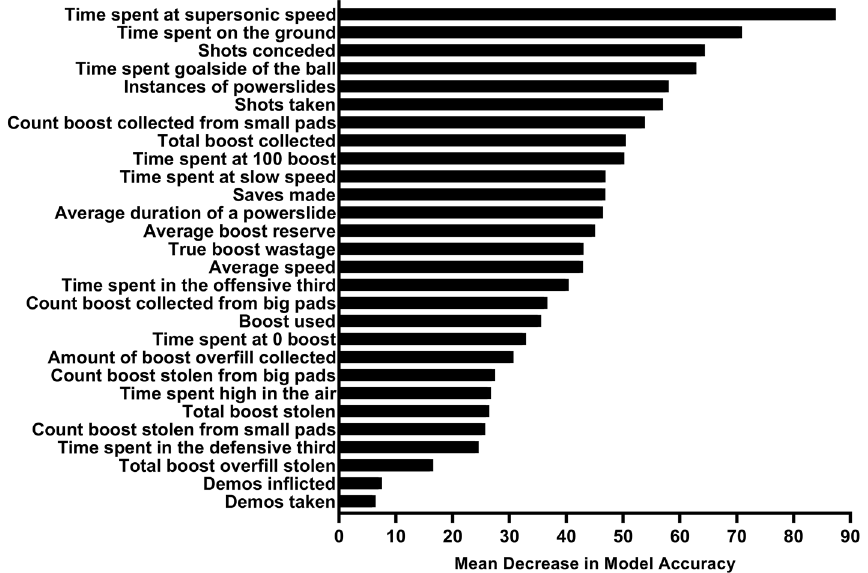
Figure 4. Metrics found to be of significant importance to the classification model created to predict the ranks of individuals playing 1v1 Rocket League, ordered by the increase in mean decrease in accuracy experienced within the model when each metric was